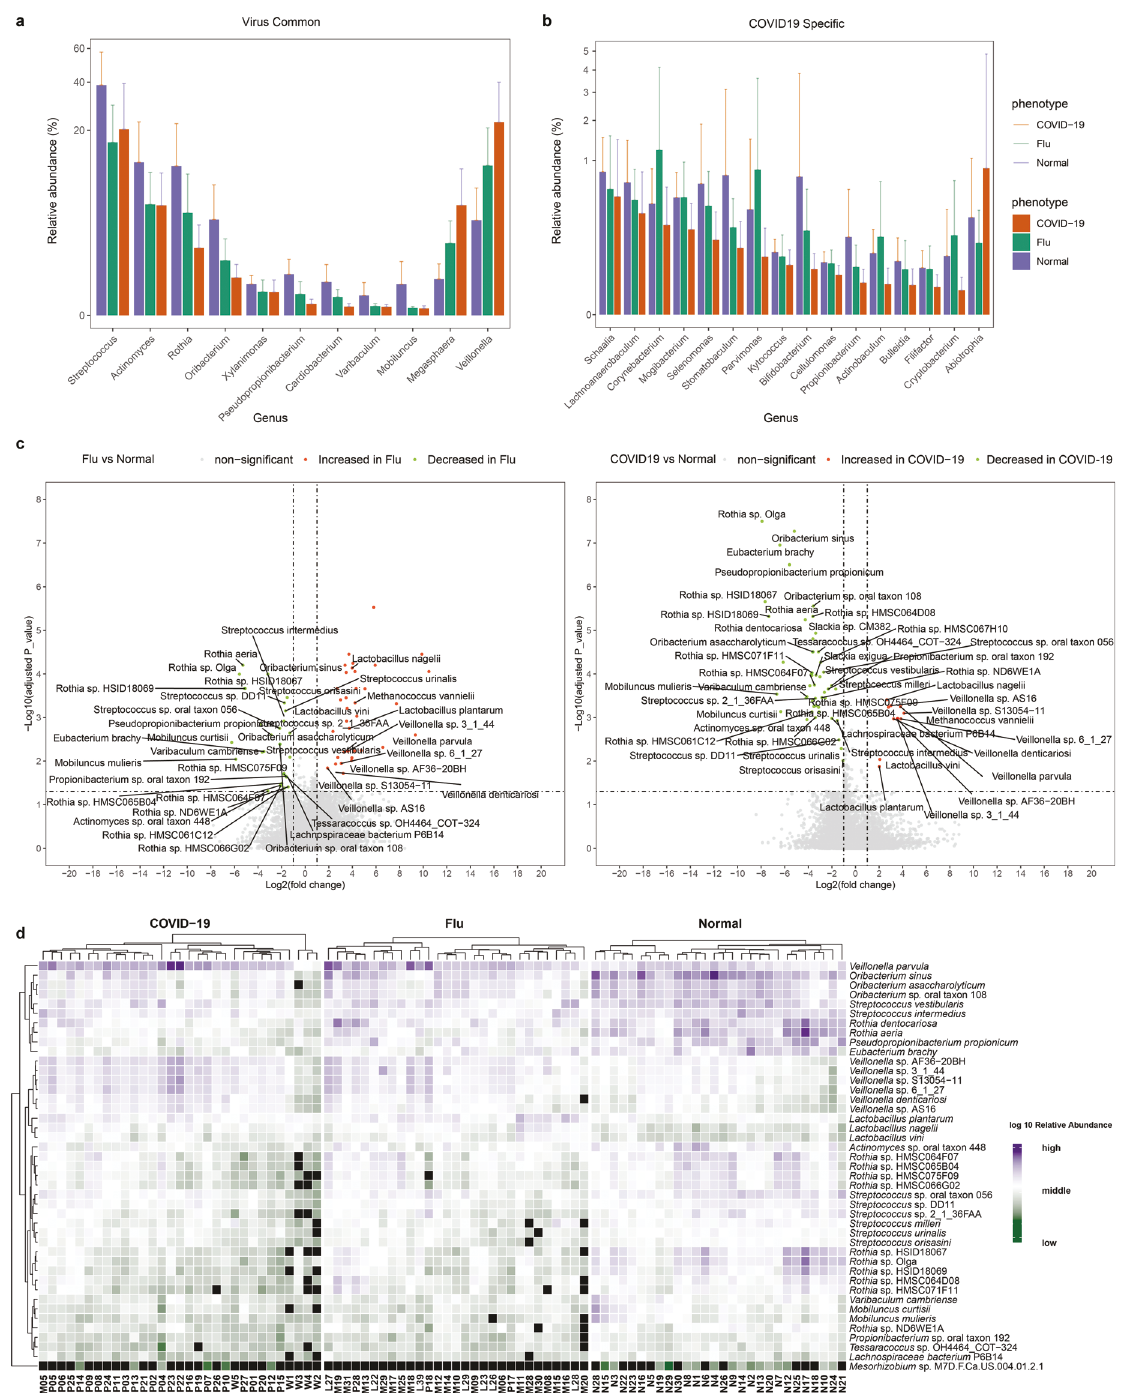
Fig. 2 Differentially abundant genera or species in COVID-19 patients, fl u patients, and healthy controls. a Relative abundance of signi fi cantly different genera at the genus level commonly identi fi ed by LEfSe when comparing COVID-19 patients with healthy controls or fl u patients with healthy subjects. These differentially expressed genera are de fi ned as “ virus common. ” b Relative abundance of signi fi cantly different genera at the genus level identi fi ed only by LEfSe when comparing COVID-19 patients with healthy controls but not detected when comparing fl u patients with healthy subjects. These genera are de fi ned as “ COVID-19-speci fi c. ” c Volcano plot representing the differentially expressed species between fl u patients and healthy controls (left), or between COVID-19 patients and healthy controls (right) with the x -axis denoting log2(fold-change) and the y -axis denoting − log10(adjusted P value). The signi fi cantly increased species in fl u or COVID-19 patients are shown in red. The signi fi cantly decreased species in fl u or COVID-19 patients are shown in green. Dashed vertical and horizontal lines re fl ect the fi ltering criteria (absolute fold-change (FC) ≥ 2.0 and FDR-adjusted P value < 0.05). d Heatmap depicting the relative abundance of signi fi cantly varied species when comparing COVID-19 patients with healthy controls and fl u patients with healthy controls. Rows (microbial taxa at the species level) and columns (samples) are ordered by hierarchical clustering based on Euclidean distance. Colors denote log10 relative abundance of each species in each sample. The relative abundance is shown in purple (high), white (middle), green (low), and black (zero) Signal Transduction and Targeted Therapy (2021)